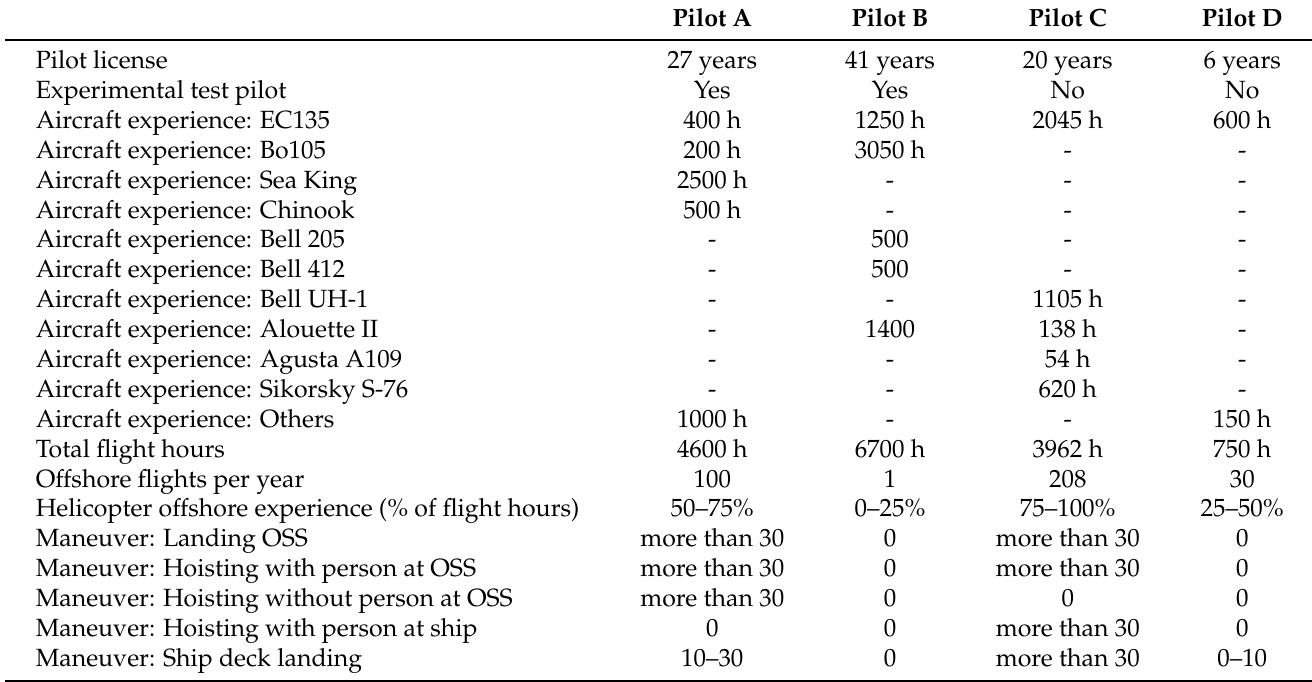
Table A1. Overview of pilot experience.